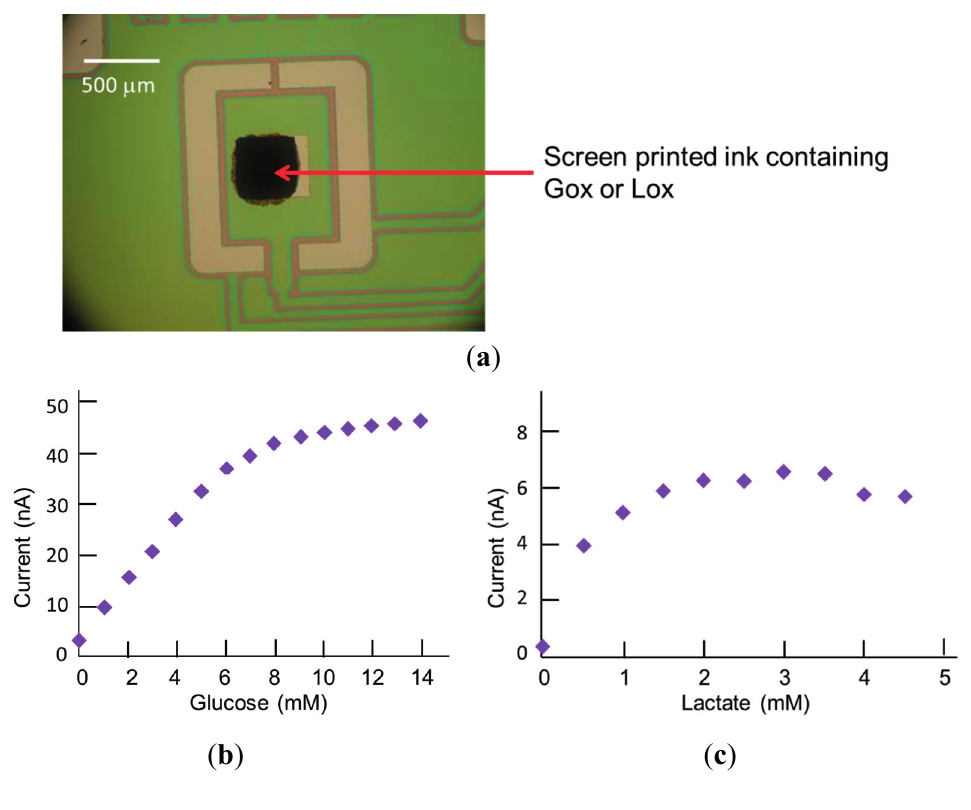
Figure 5. Enzyme biosensors: ( a ) Photograph of microfabricated screen-printed microbiosensor showing screen-printed working electrode ink deposit ( b ) Calibration plot for glucose biosensor in phosphate buffer ( c ) Calibration plot for lactate biosensor in phosphate